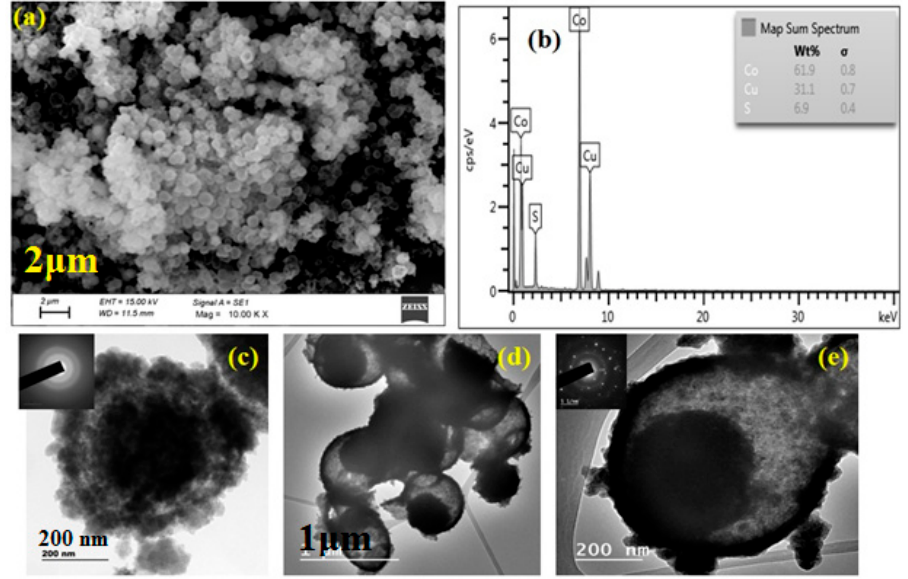
Figure 2. ( a ) Scanning electron microscopy (SEM) images ( b ) EDS spectra of CuCo 2 S 4 yolk-shell structure ( c ) Transmission electron microscopy (TEM) images of amorphous CuCo 2 S 4 ( d , e ) crystalline CuCo 2 S 4